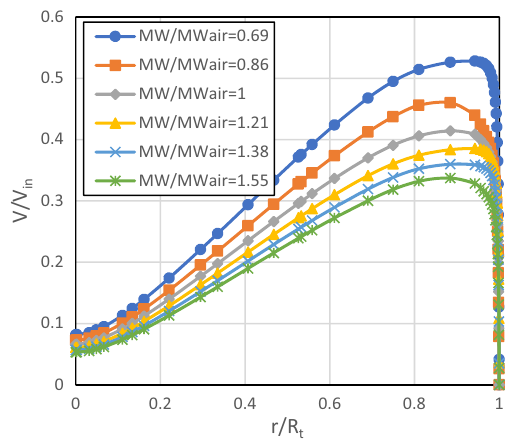
Fig. 8 Dimensionless velocity profiles versus dimensionless radial direction plotted at z∕L = 0.63 for various molecular weight ratios with 400 kPa at the inlet, 0 kPa at the cold outlet and 30 kPa at the hot